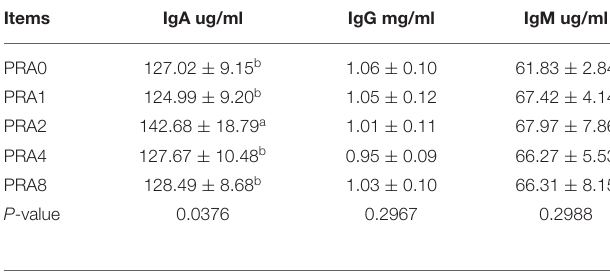
TABLE 8 | Effects of dietary PRA extract levels on small intestine of raccoon